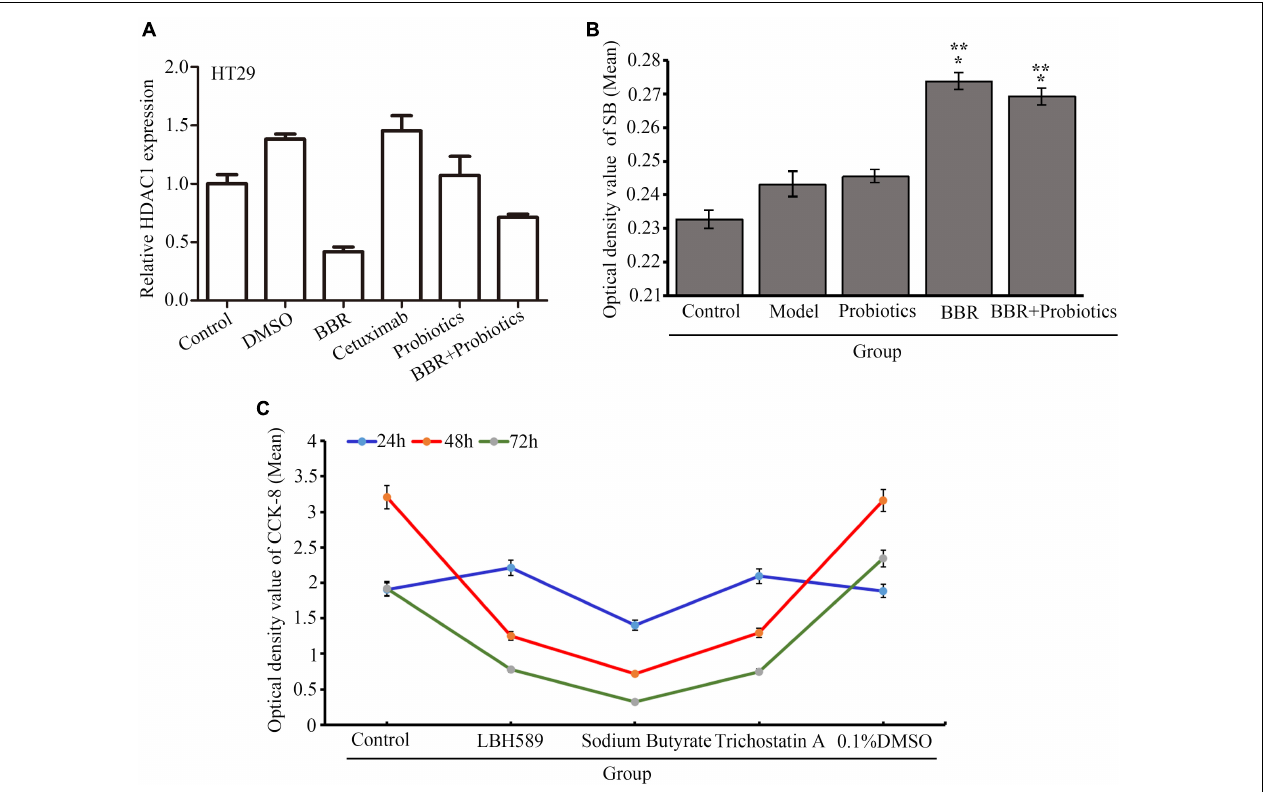
FIGURE 6 | (A) Relative level of HDAC1 mRNA in the HT29 cells with different conditions. (B) Expression of sodium butyrate (SB) in the serum of mice treated with BBR and probiotics (LCBLEP). (C) Description of proliferation in the HT29 cells treated with three kinds of HDAC inhibitors at different times using CCK-8. * p < 0.05 vs. control, ** p < 0.05 vs. the model